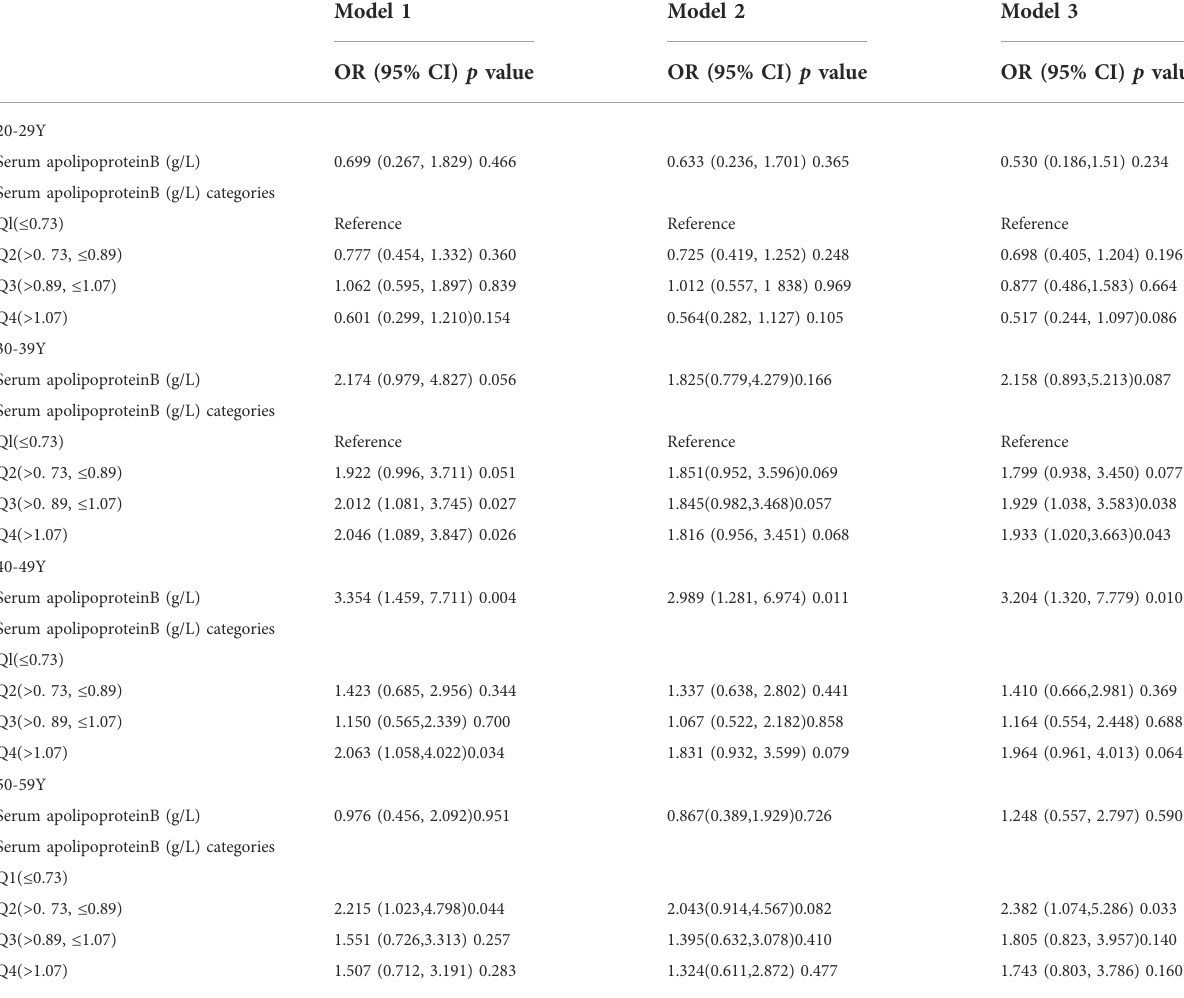
TABLE 8 Association between Serum apolipoprotein B (g/L) and and the risk of osteopenia or osteoporosis (subgroup analysis strati fi ed by